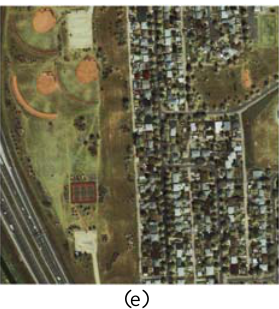
Figure 1. Illustrations of the fusion results using IKONOS images. (a) re-sampled multispectral image; (b)panchromatic image; (c) DFRNT-IHS fused image; (d) DFRNT fused image; (e) IHS fused